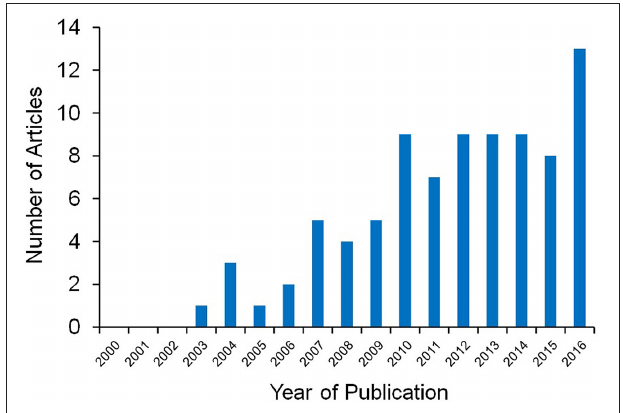
FIGURE 1 | Since the seminal work by von Schantz et al. (1999), most of the articles on the role of oxidative stress as a cost of and constraint on honest signaling have been published in the last